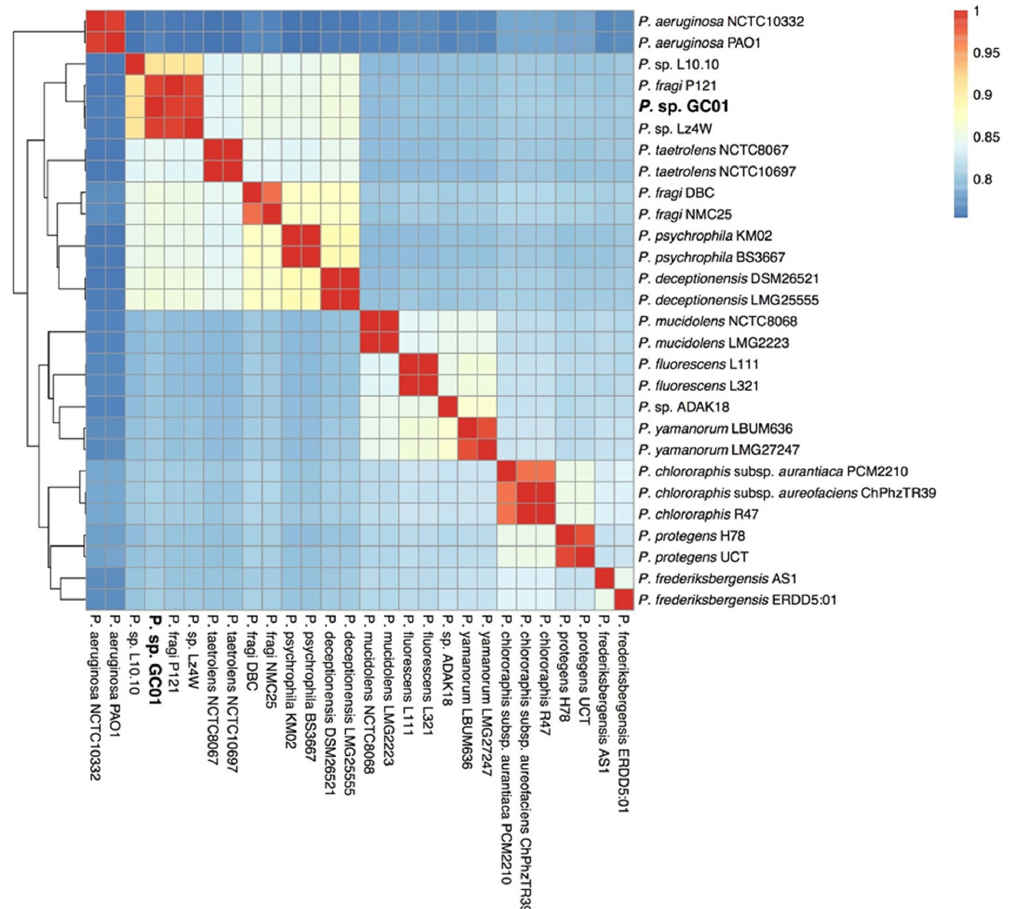
Figure 2. Heatmap displaying the relationships (hierarchical clustering) between the 28 Pseudomonas strains based on ANI analysis. The color gradients show the percentage of identity shared by each pair of genomes, from lowest (blue) to highest (red).